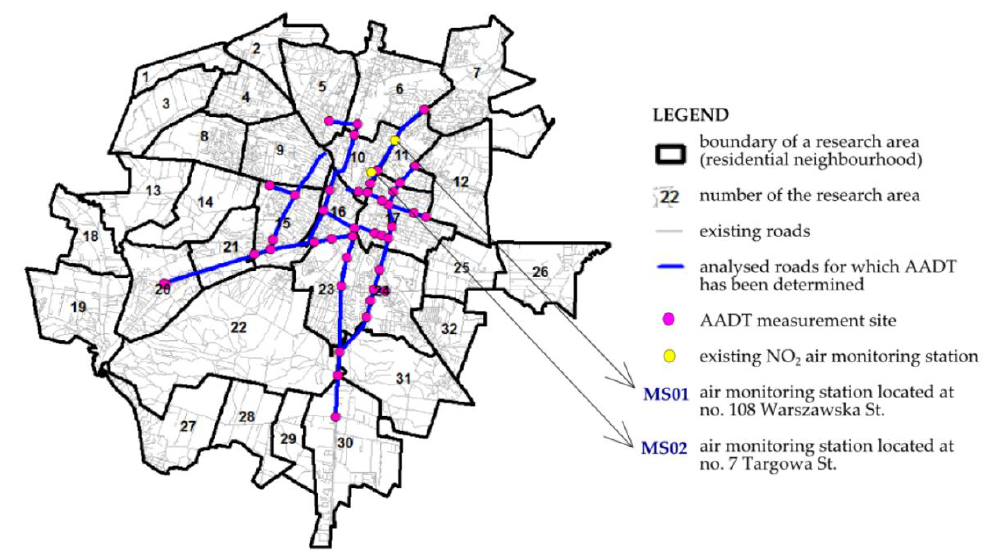
Figure 10. Location of AADT road traffic intensity measurement points, with the position of air monitoring stations against the research areas. Table 7. Characteristics of the analyzed roads along with the characteristics of building design in the research areas.